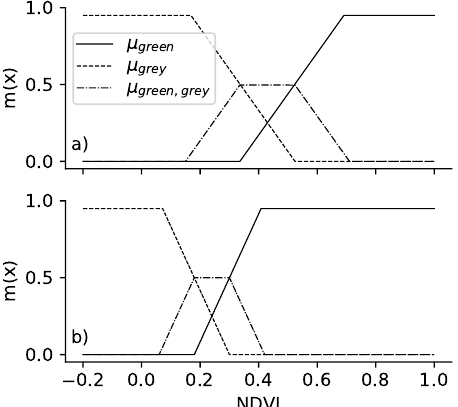
Figure 4. Basic probability assignment for greenness based on the NDVI. Due to different spectral characteristics, the functions were adapted separately to the Sentinel-2 ( a ) and aerial imagery ( b ) using fuzzy C-means